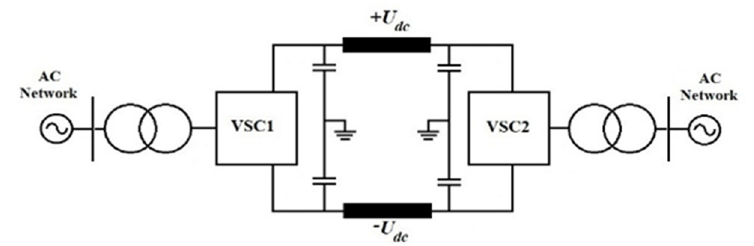
Figure 26. VSC-HVDC—pseudo-bipolar connection.